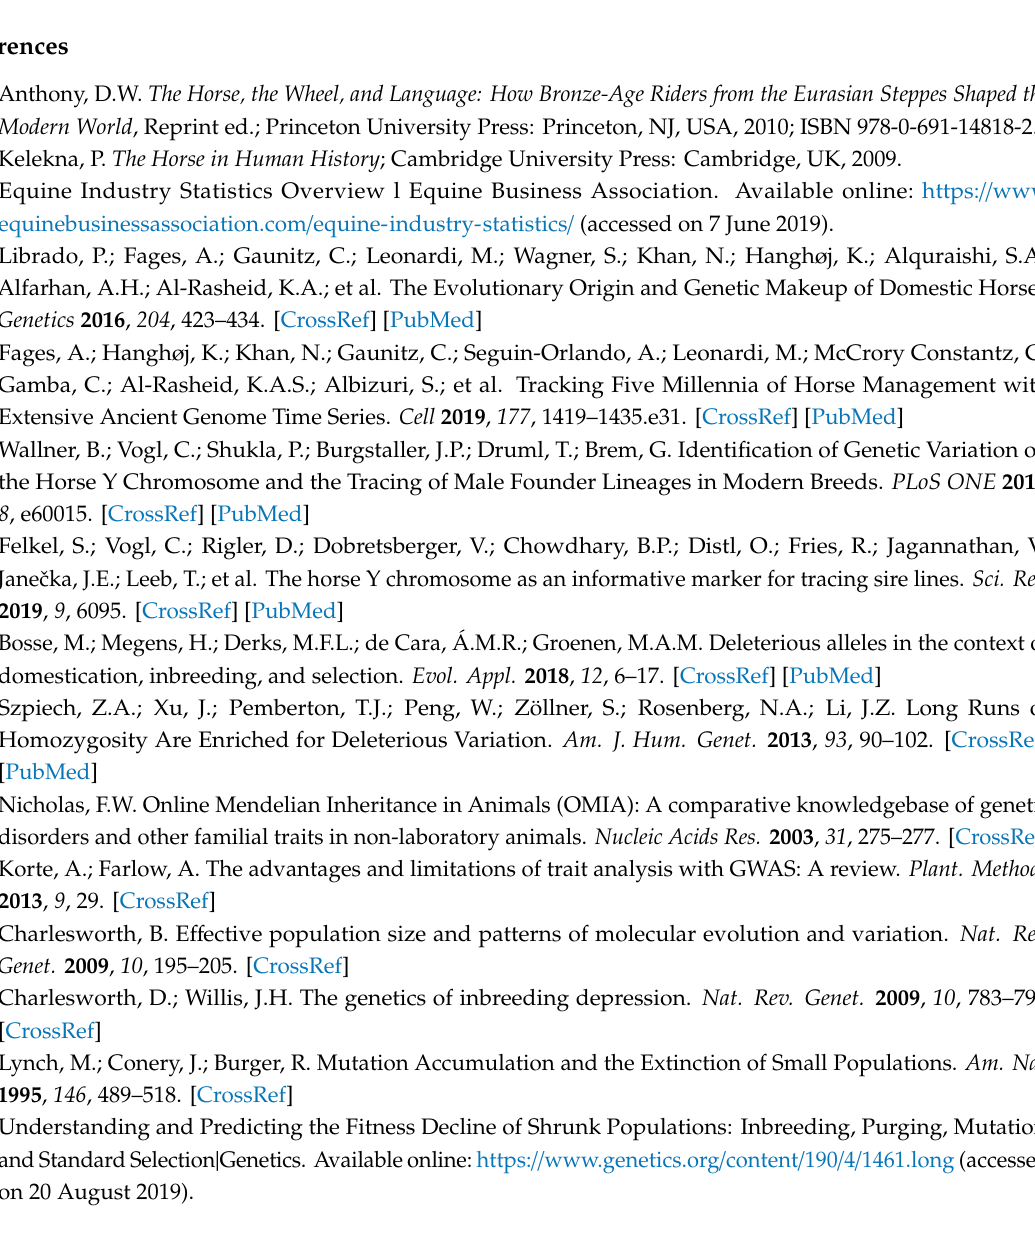
Table S1: Metadata for 175 modern horses investigated in this study. Table S2: Metadata for 153 ancient horses investigated in this